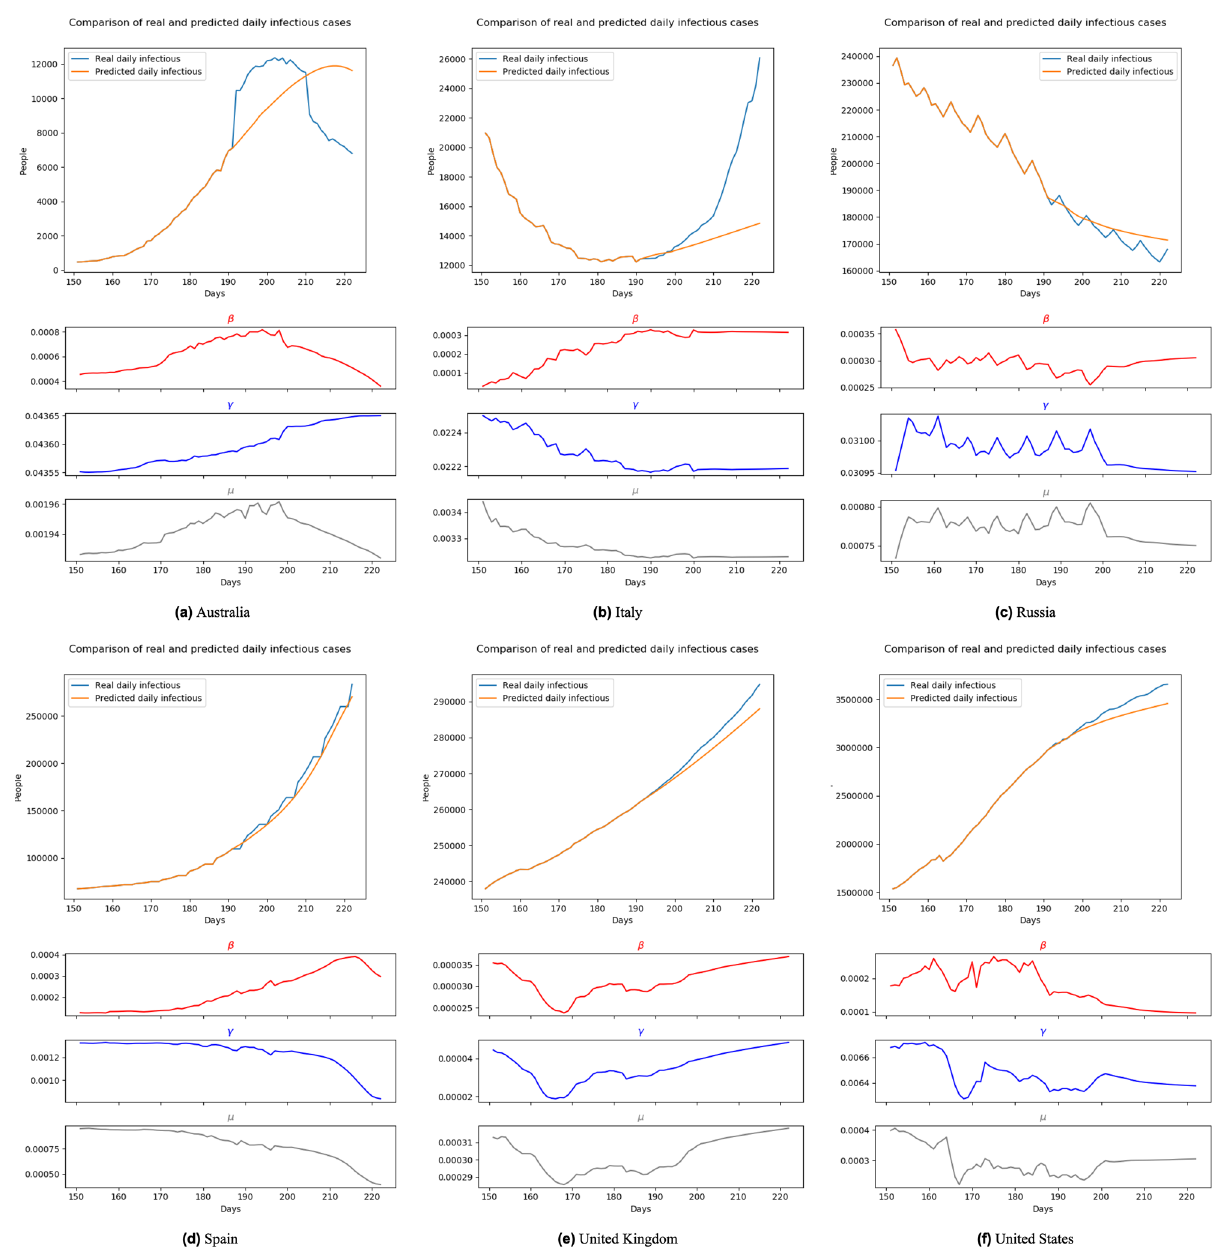
Figure 12. Forecasting results with transition rates of 192th–222nd day (Aug. 1st 2020–Aug. 31st 2020) using data of 182nd–191th day (Jul. 22nd 2020–Jul. 31st